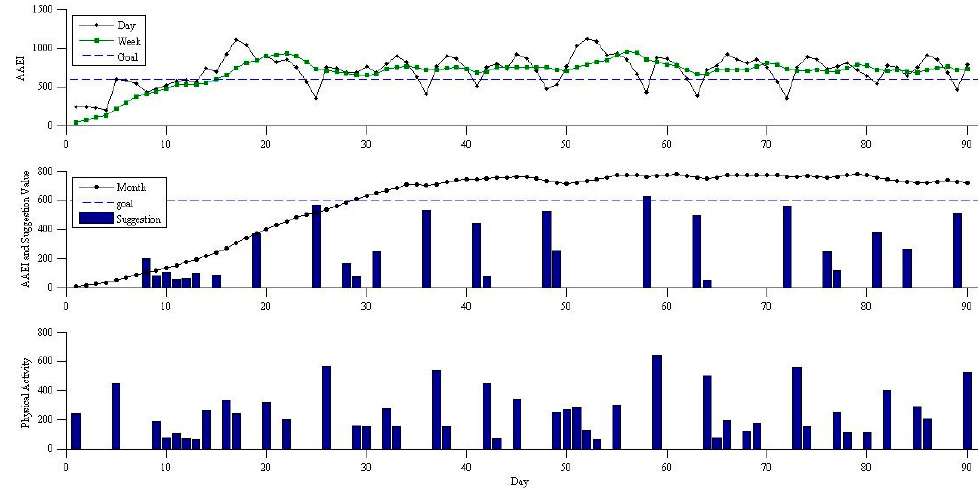
Figure 10. Physical activity and corresponding AAEI with prompting. Simulation model parameters- Intensity: 5 MET; Duration: 30 min; Frequency: 3.